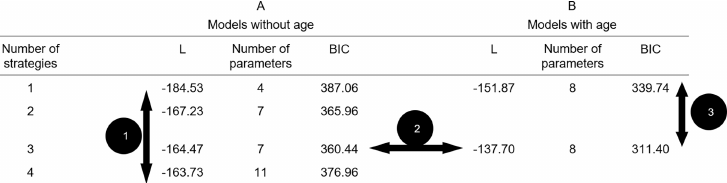
Fig 1. Goodness-of-fit measures for latent class models. Note : L = Log Likelihood, Number of parameters = number of feely estimated parameters minus the number of parameters estimated at the boundary, BIC = Bayesian Information Criterion. The arrows correspond to the first three steps in studying variability (see Results